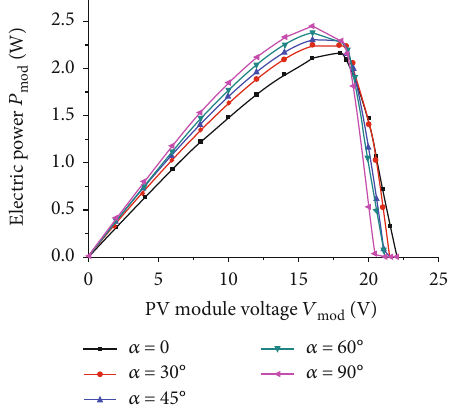
Figure 5: Power-voltage characteristic curves of the PV module vs. inclination angle α ; E = 630 W.m -2 and B = 15